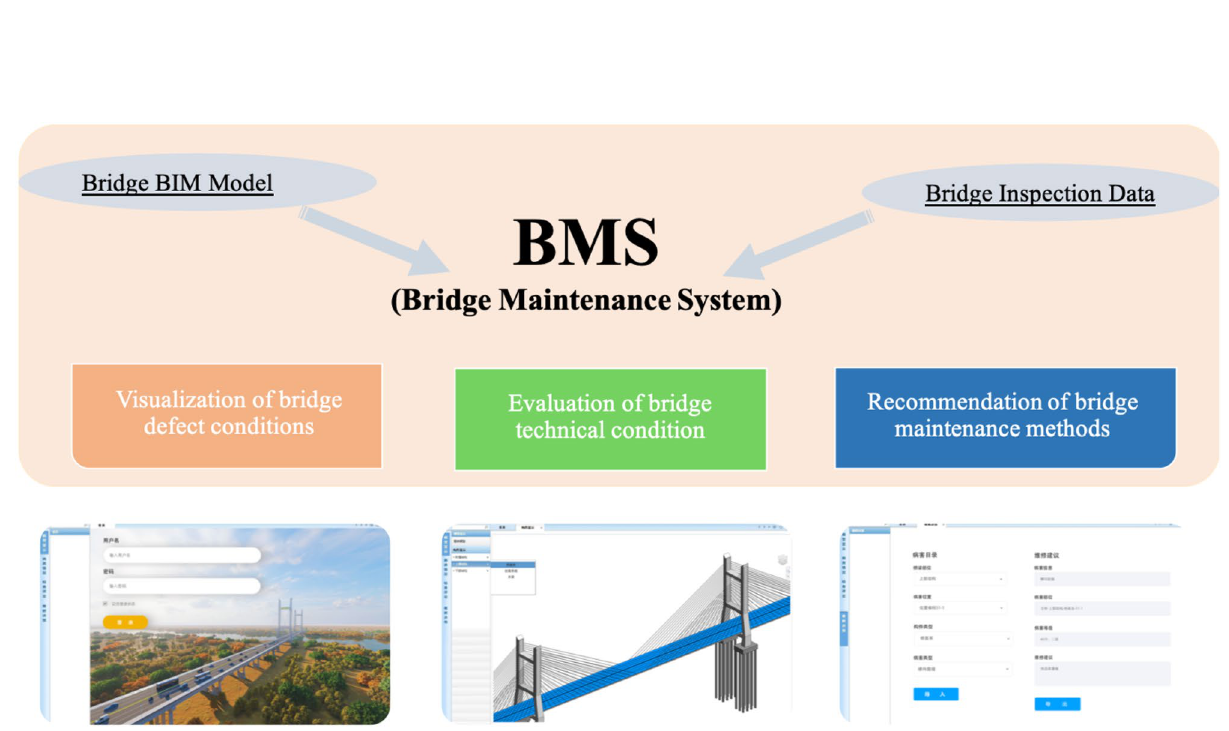
Figure 14. BMS utilization